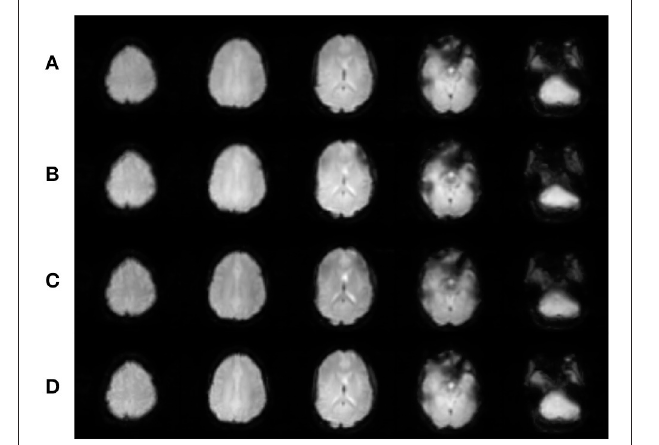
FIGURE 3 | One-sample t -test maps for each of the four EPI sequences. (A) SHORT, TR = 700 ms; (B) AVG2, TR effective = 1400 ms; (C) AVG4, TR effective = 2800 ms; (D) REF, TR = 1440 ms. Color bar is given in terms of T -statistic, and maps are thresholded at p < 0.05, Family-Wise